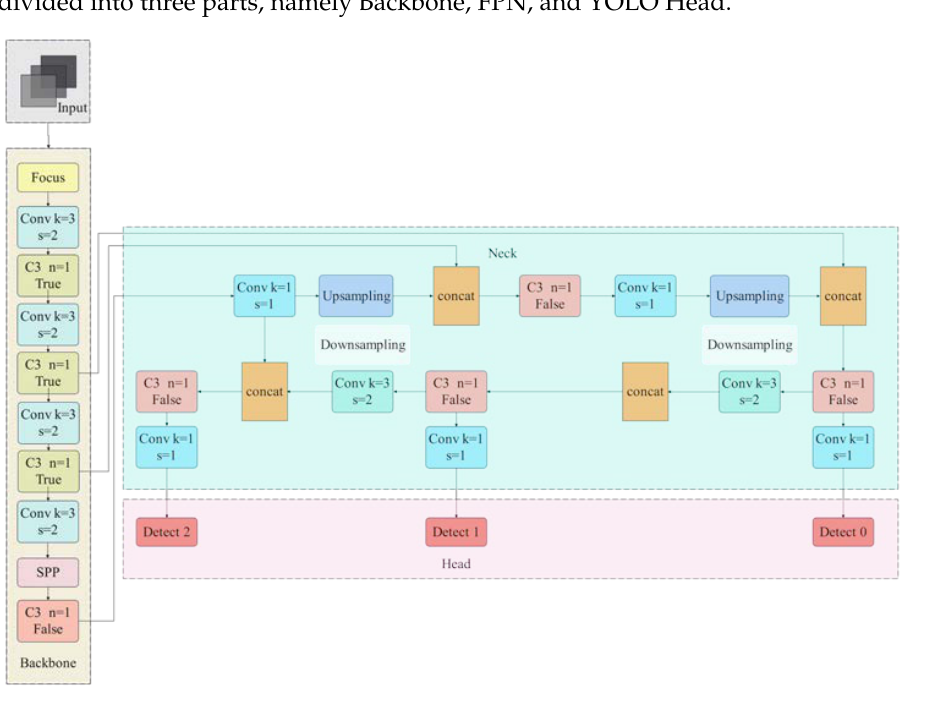
Figure 2. Basic structure diagram of YOLOv5.